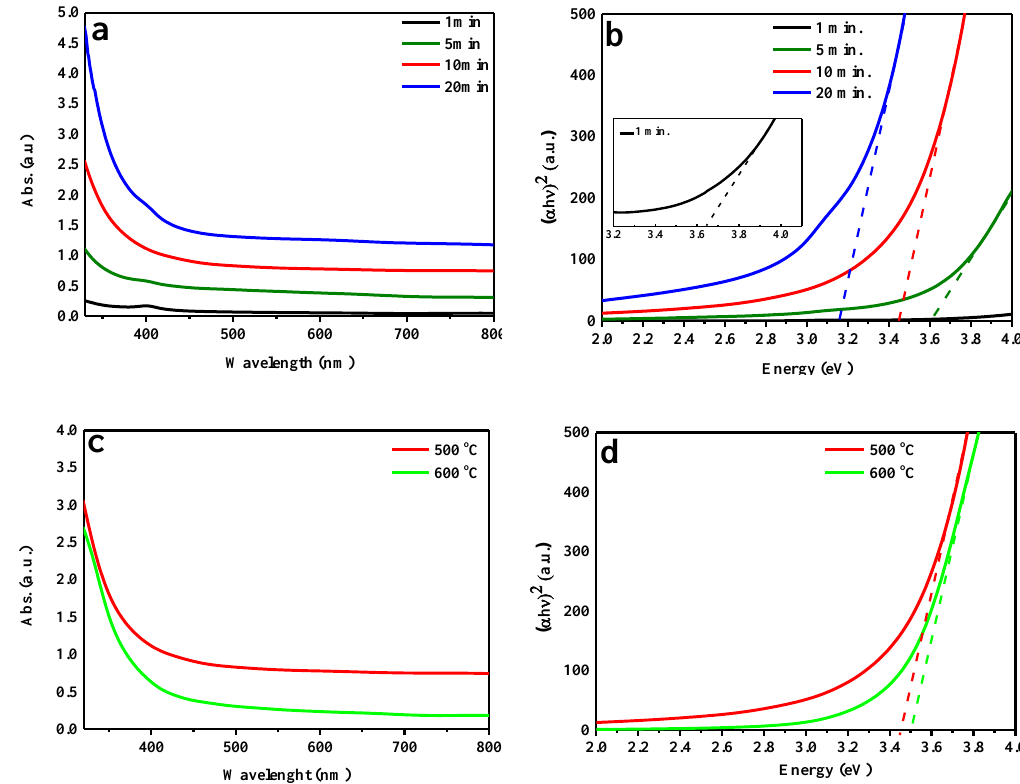
Figure 4. Ultraviolet–visible (UV-Vis) absorption spectra and bandgap of W 18 O 49 films as a function of deposition time ( a and b ), and UV-Vis absorption spectra and Tauc’s plot of W 18 O 49 films ( c and d ) fabricated by post-annealing of sputtered W films at 500 and 600 °C in air.